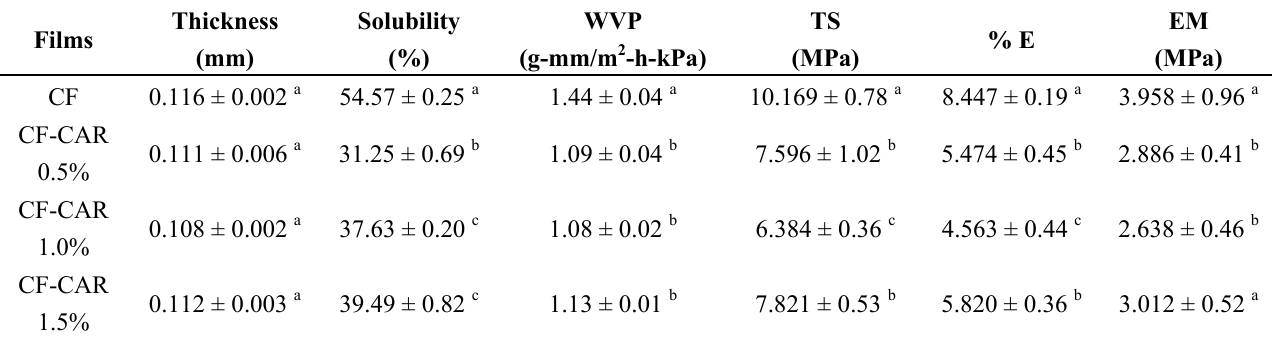
Table 1. Solubility, WVP and mechanical properties of CF and